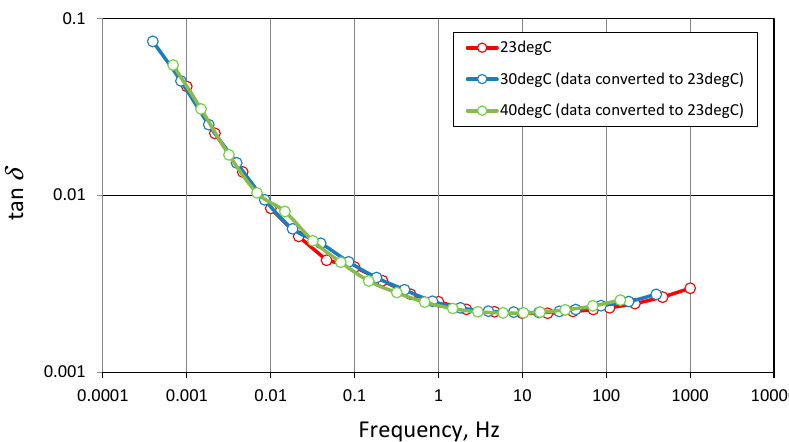
Figure 6. Dielectric response of the bushing insulation with uniform temperature distribution; measurements made for temperatures: 23 °C, 30 °C, and 40 °C, subsequently converted to 23 °C, assuming activation energy at the level of 0.9 eV.